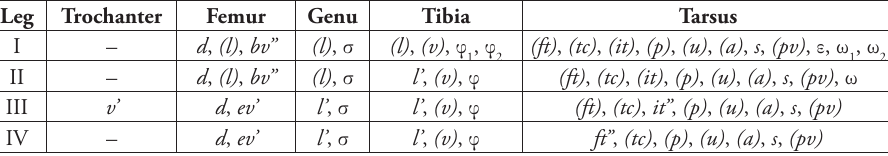
Note: Roman letters refer to normal setae, Greek letters to solenidia (except ε = famulus). Single